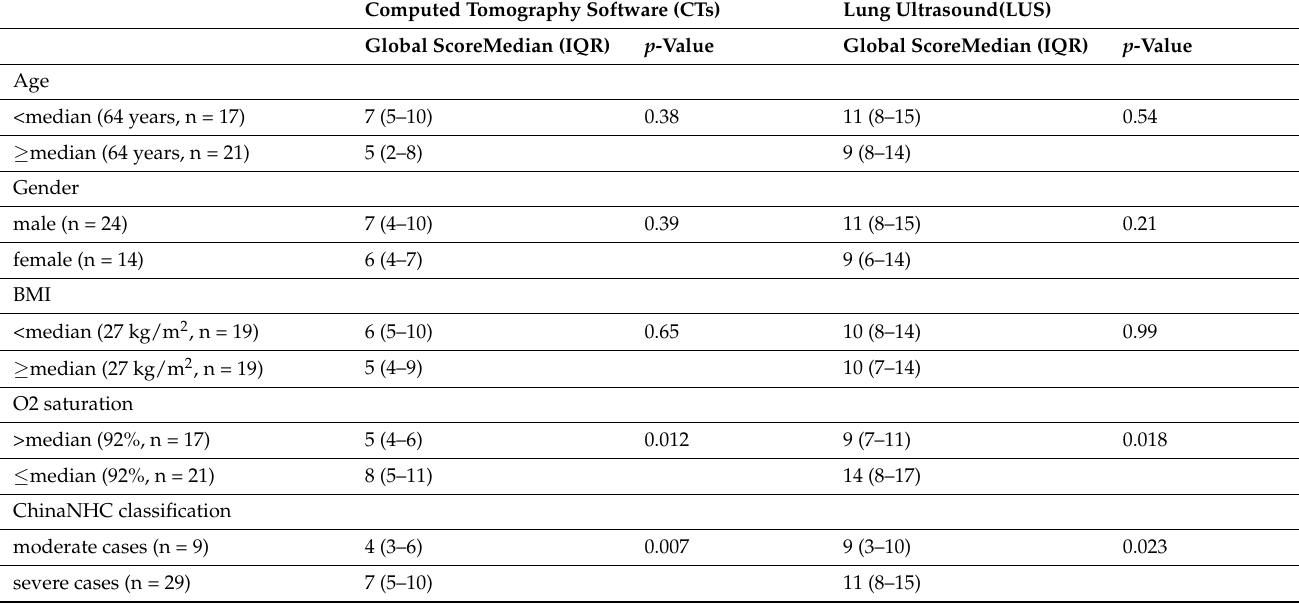
Table 3. Association between baseline radiographic features of lung aeration and demographic data, clinical classification, or laboratory indices of inflammation.